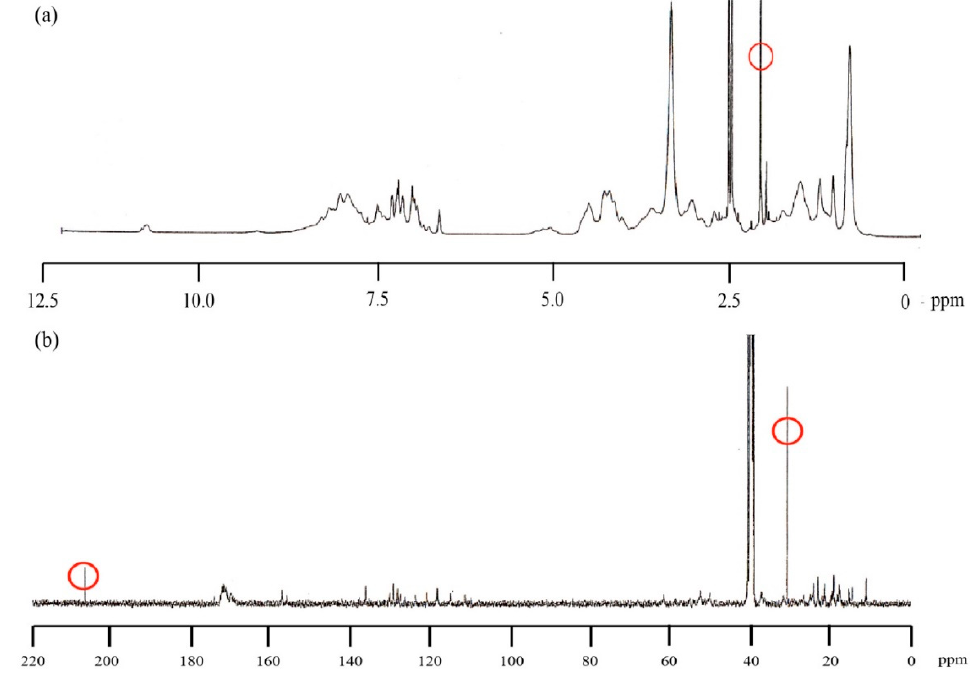
Figure 1. 1 H Nuclear-magnetic resonance (NMR) and 13 C NMR spectra of CHLysozyme in DMSO-d 6 at 25 °C. ( a ) 1 H NMR spectrum, and ( b ) 13 C NMR spectrum, CHLysozyme concentration: 21.4 mg/mL.